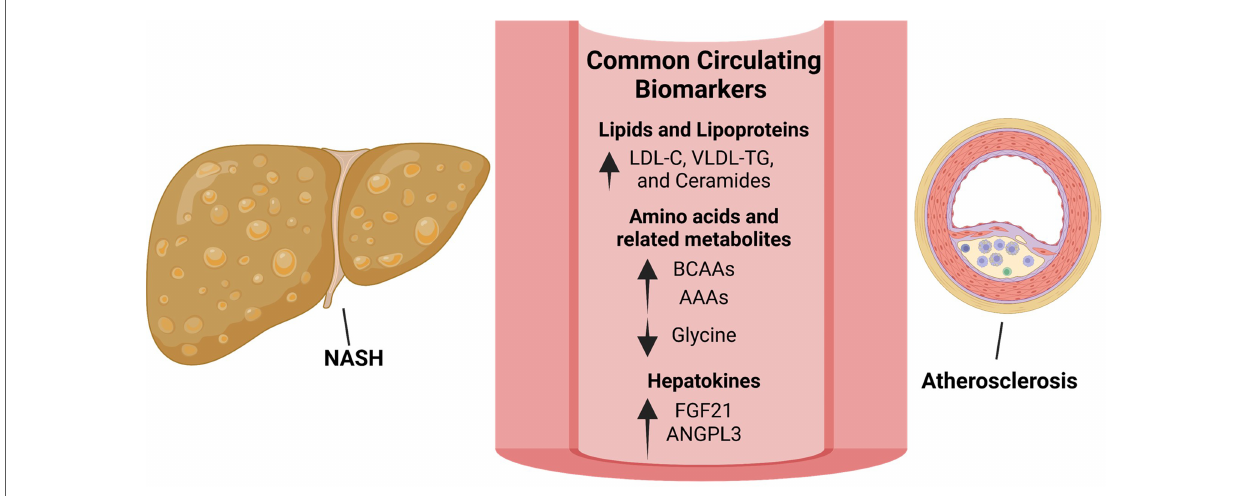
FIGURE 2 Biomarkers linking NAFLD/NASH and ASCVD offer potential therapeutic strategies. Lipid species that are increased in both NAFLD/NASH and ASCVD include low-density lipoprotein-cholesterol (LDL-C), very low-density lipoprotein (VLDL) and triglycerides (TG) as well as ceramides. Although signi fi cantly lowering ASCVD, LDL-C reduction using statins has shown inconsistent results with regards to NASH treatment. Targeting ceramide synthesis have shown promising results in rodent models of NAFLD/NASH and ASCVD and warrants clinical evaluation. Amino acid metabolism is commonly dysregulated in NAFLD/NASH and ASCVD with circulating branched-chain amino acids (BCAAs) and aromatic amino acids (AAAs) increased and glycine decreased in both diseases. In rodent models and small-scale clinical studies, glycine-based treatments reduced steatohepatitis and atherosclerosis warranting clinical evaluation in larger cohorts. The hepatokines, fi broblast growth factor-21 (FGF-21) and angiopoietin like 3 (ANGPTL3), are increased in both NAFLD/NASH and ASCVD. Interestingly, approaches to inhibit hepatic ANGPTL3 have shown promise in treating dyslipidemia but were associated with increased hepatic steatosis and markers of liver injury. Despite being increased in both diseases, FGF21 analogues are protective in rodent models of NASH and atherosclerosis as well as in patients with